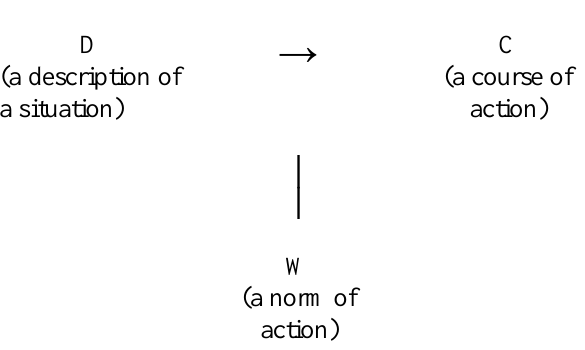
The components of a practical